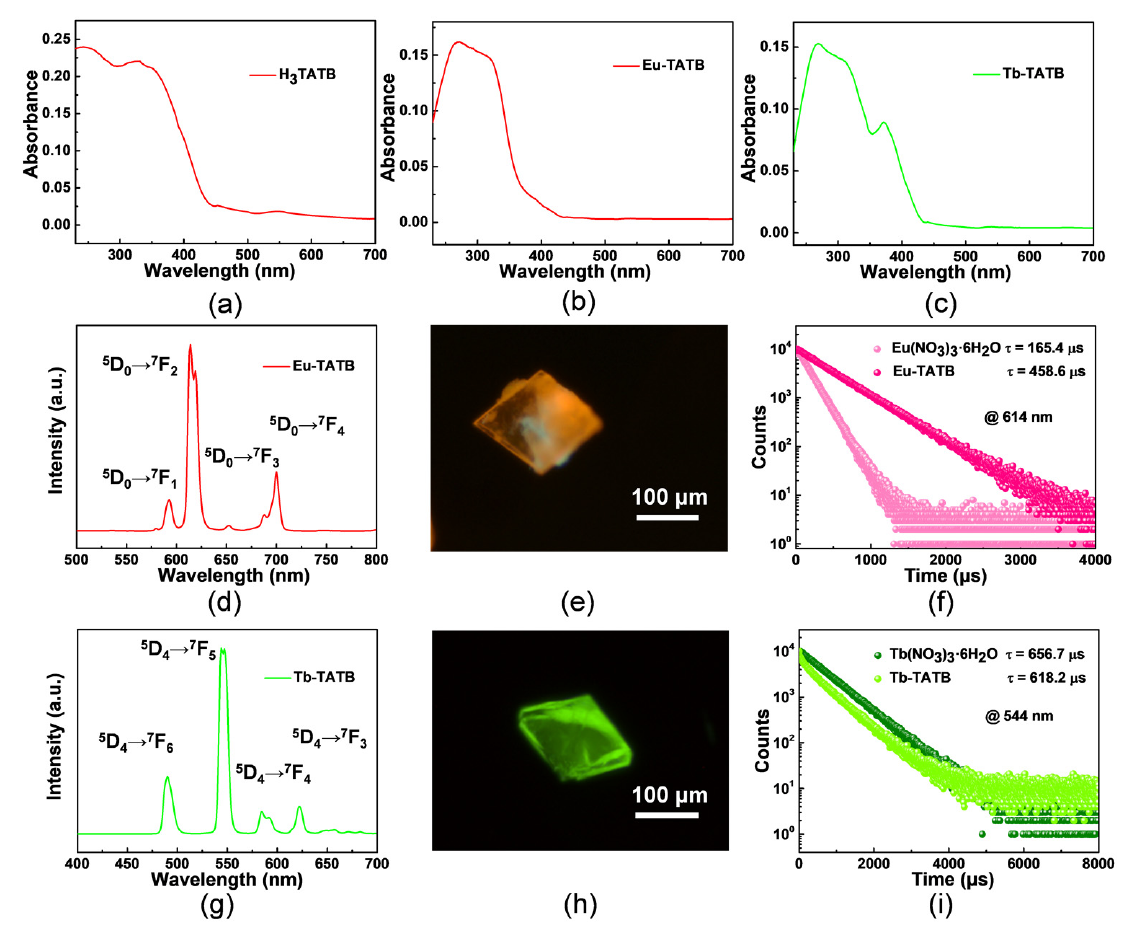
Figure 4. The solid-state UV-Vis absorption spectra of ( a ) H 3 TATB, ( b ) Eu-TATB, and ( c ) Tb-TATB. ( d , g ) Emission spectra and ( e , h ) photoluminescence microscope images of Eu-TATB and Tb-TATB square crystal. ( f ) PL lifetime spectra of Eu(NO 3 ) 3 ·6H 2 O and Eu-TATB ( λ em = 614 nm). ( i ) PL lifetime spectra of Tb(NO 3 ) 3 ·6H 2 O and Tb-TATB ( λ em = 544 nm).